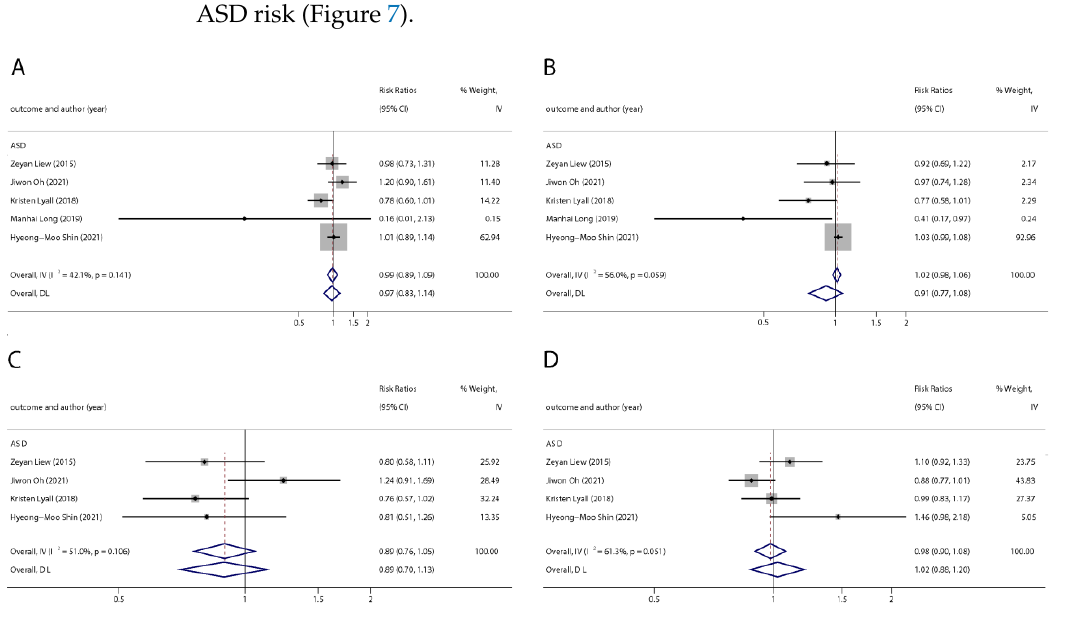
Figure 5. Pooled odds ratios for ASD associated with per 1 ng/mL increase in polyfluoroalkyl sub-